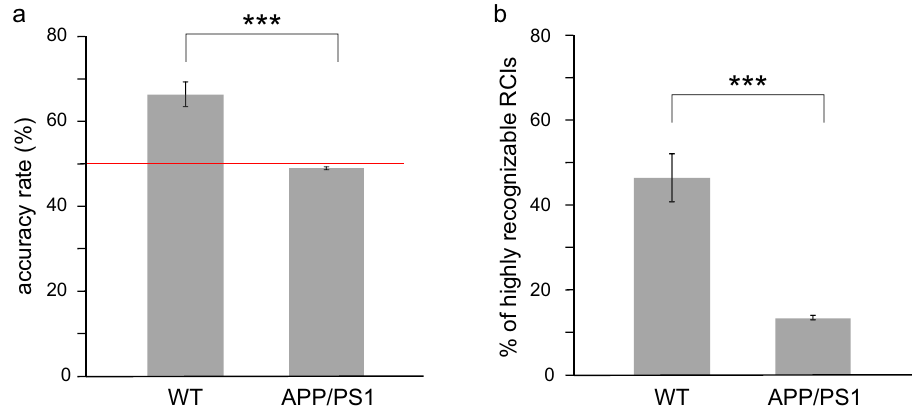
Figure 2. Recognition of a post-learning alteration of RCIs differs in the two groups. ( a ) Average accuracy rate was equal to the chance level in the APP/PS1 mice and significantly lower compared to the WT group (APP/ PS1: 49%, WT: 66.29%, p = 0.0001, t = 6.0435, t-test, N = 6). ( b ) Whereas in the WT group almost half of tested RCIs was correctly recognized in at least 8 over 10 sessions, the percentage of such highly recognizable RCIs was nearly three times lower in APP/PS1 animals. (APP/PS1: 13.47%, WT: 46.39%, p = 0.0006, t = 4.9811, t-test, N = 6). All box plot represent mean values, vertical bars represent standard errors Abbreviations: *** p < 0.001, ** p < 0.01, * p <